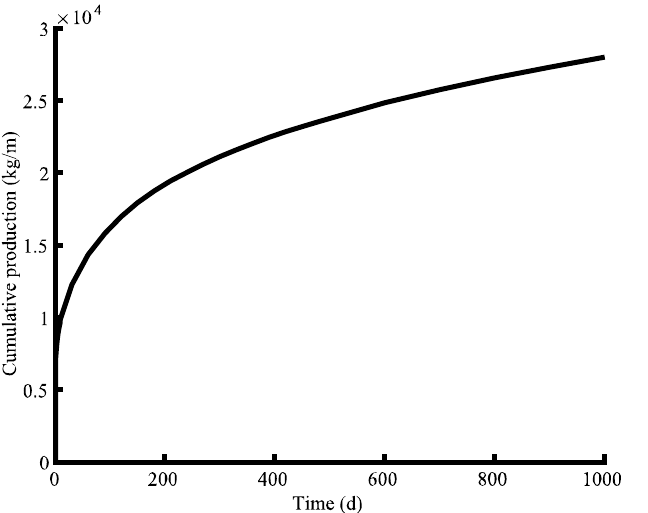
Figure 16. Cumulative production curve during the hydro‑mechanical coupled production